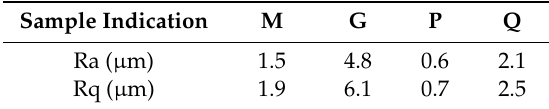
Table 3. Roughness measurements of the copper R300 rods.